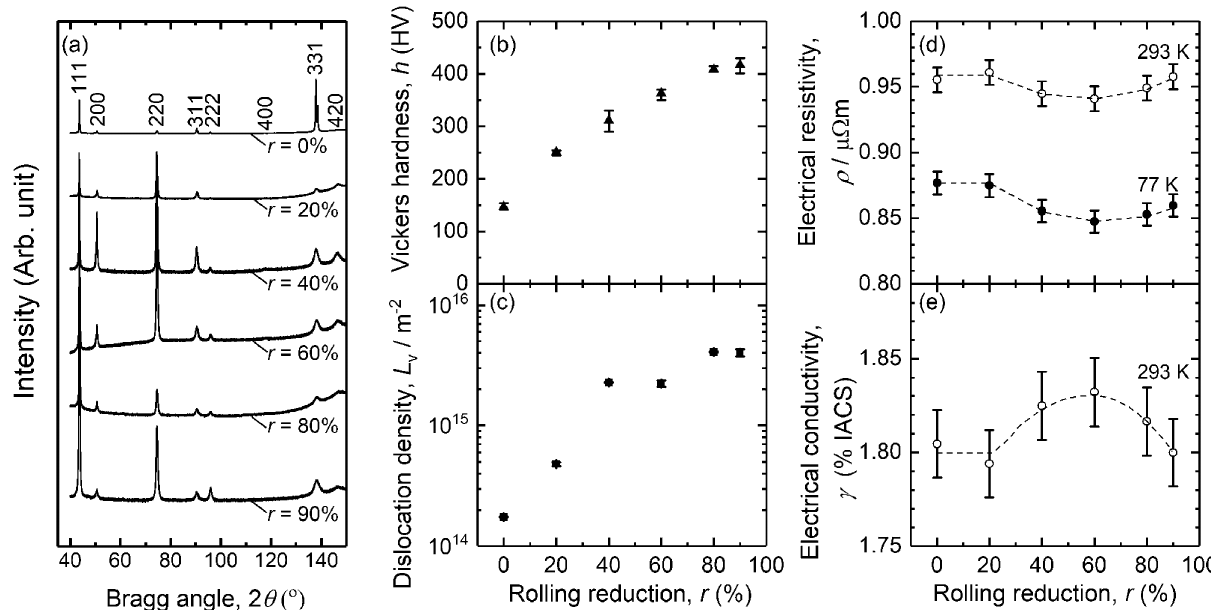
Figure 2. Rolling reduction dependence with the rolling reduction between 0 and 90% of CrMnFeCoNi alloy, ( a ) XRD spectra, ( b ) Vickers hardness, ( c ) dislocation density evaluated using XRD data, ( d ) electrical resistivity at 77 K and 293 K, and ( e ) electrical conductivity at 293 K.